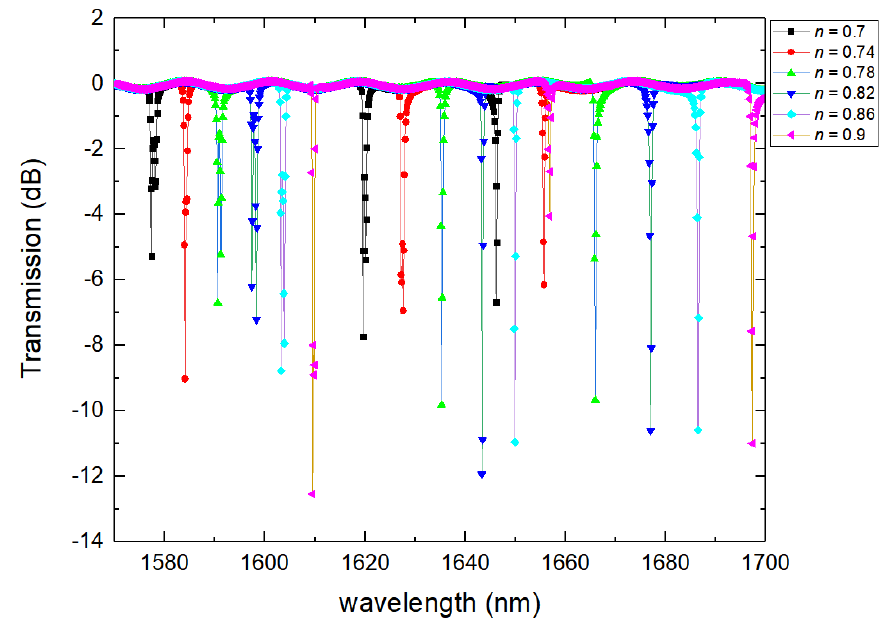
Figure 8. Output spectra under different duty cycles.